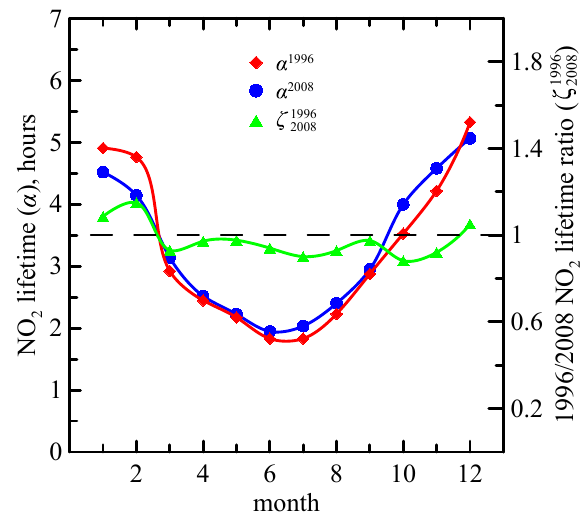
Fig. 11. Monthly values of the lifetime ( α ; see Eq. 3) of the tropo- spheric NO 2 columns over the East China as evaluated with the CHIMERE model using the EDGAR v4.2 emission data for the years 1996 and 2008, along with the corresponding values of ζ 1996 (see Eq. 5) for different months. Note that some irregular variations in ζ 1996 are mainly due to meteorological variability. 2008 were scaled with the scale factor ranging from